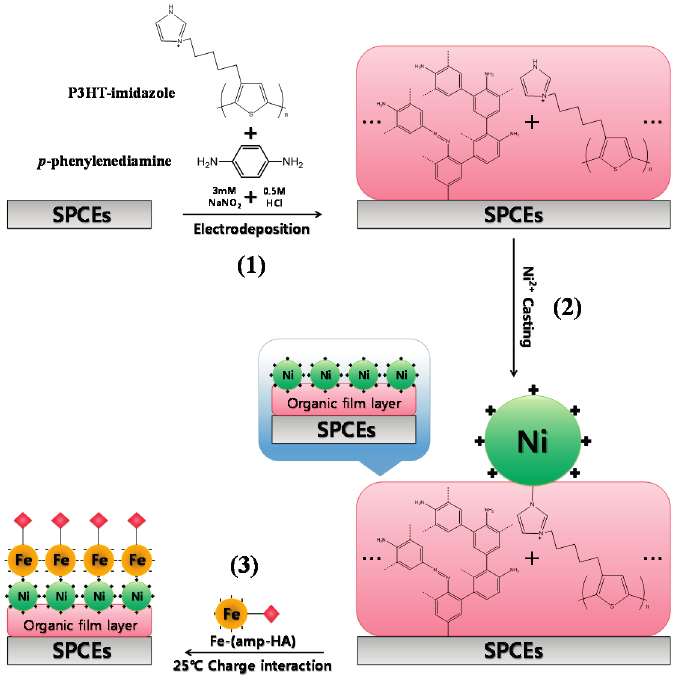
Figure 1. Schematic representation of the fabricating SPCEs/Organic film/Ni/Fe-HA for heterogeneous electrochemical